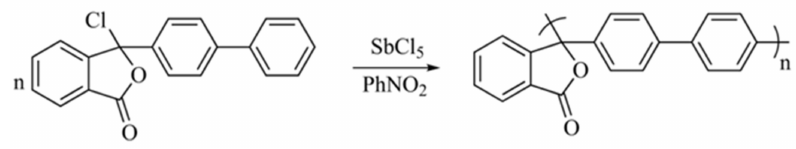
Figure 2. Poly(diphenylene phthalide) C4 synthesis